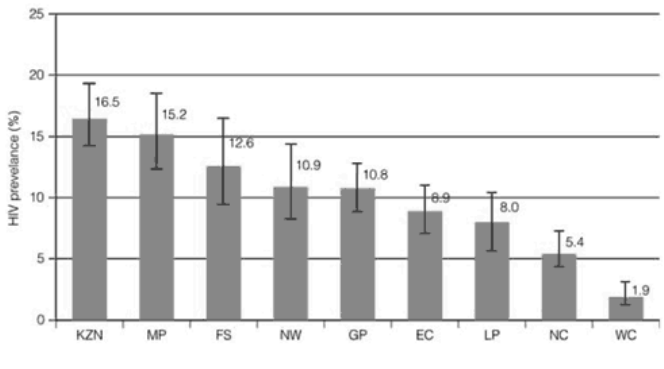
FIGURE 5: HIV prevalence per province Source: Human Sciences Research Council